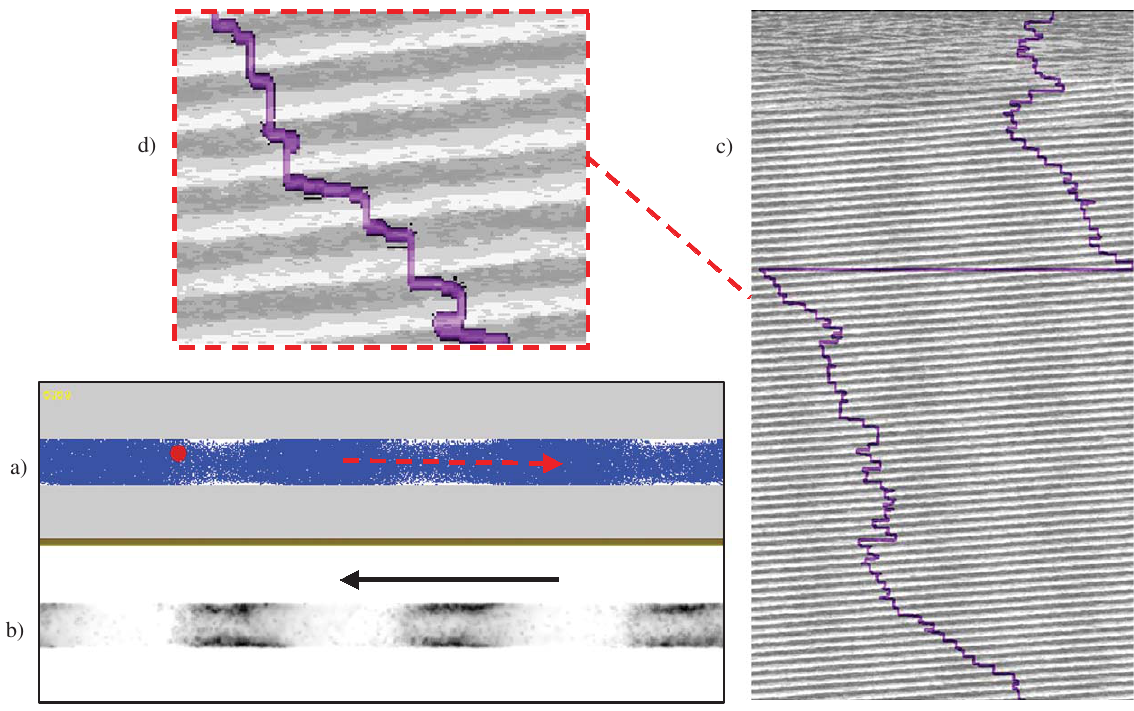
Fig. 12. Collective particle drift is opposite to the direction of wave propagation. a) Particle positions and tracer particle (circled), b) Chemoat- tractant wave propagation, c) Space-time plot overlaid with tracer particle position, d) Enlarged portion showing tracer particle movement (horizontal movement) tends to occur in vacant (high chemoattractant flux)